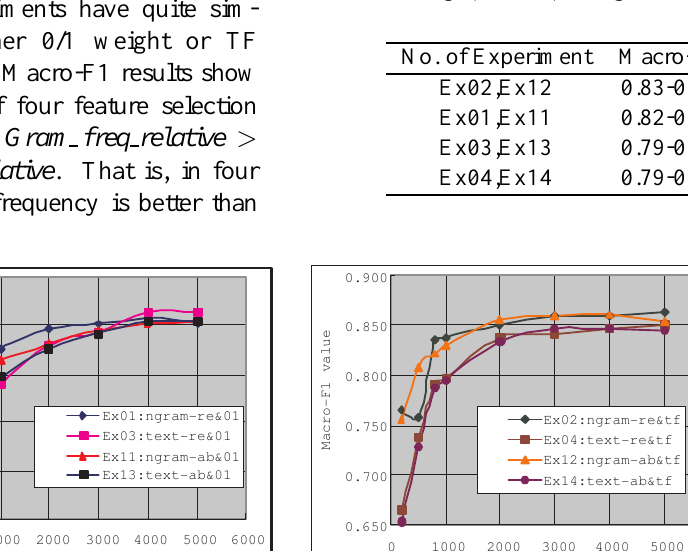
Table 4. The scope of Macro-F1 and Micro-F1 in eight experi- ments (using 1,000 to 5,000 n-grams).